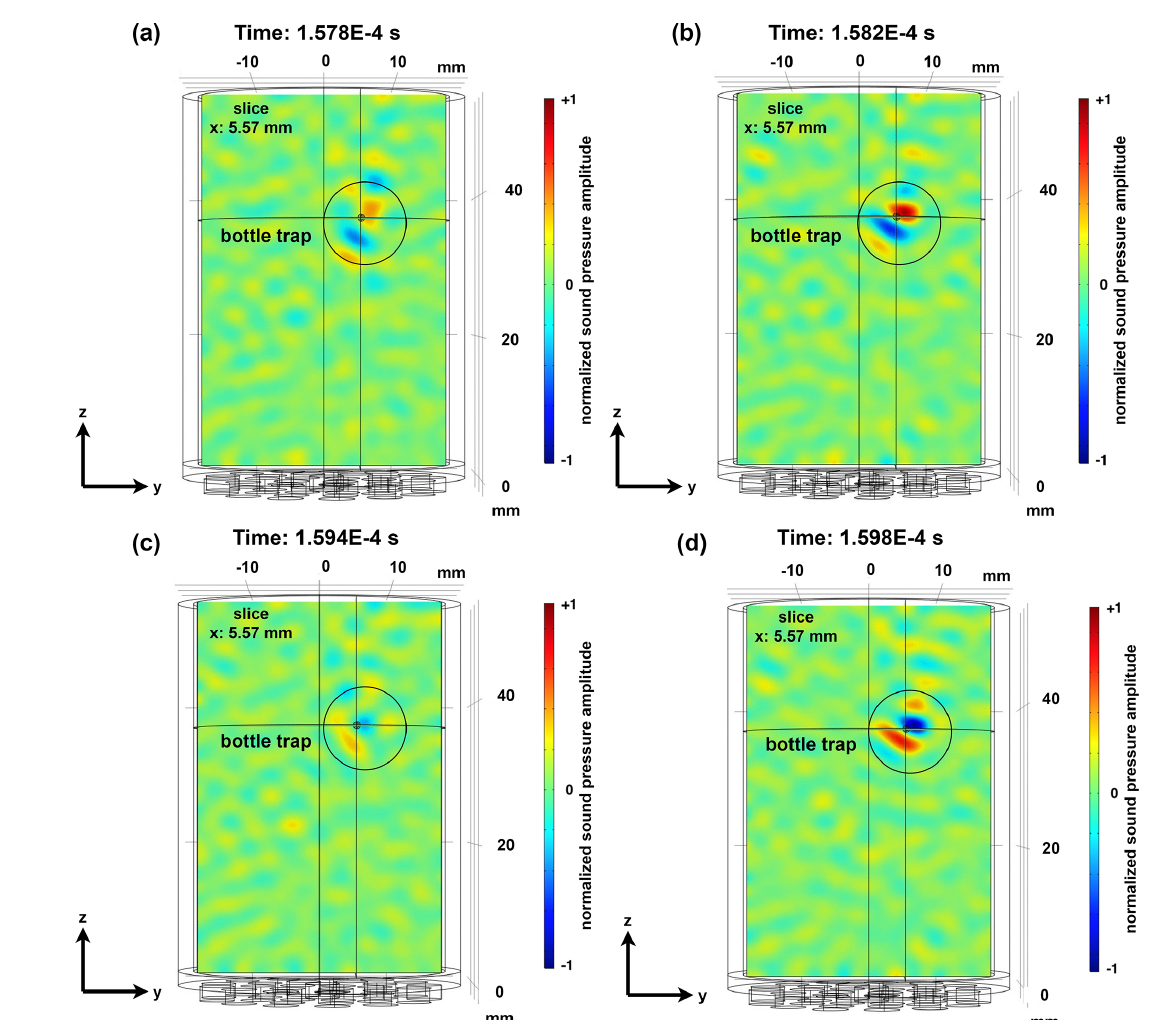
Figure A2. Intensity plot of the acoustic pressure field of the bottle trap during the focusing process in the y – z plane in the cylindrical vessel during four different